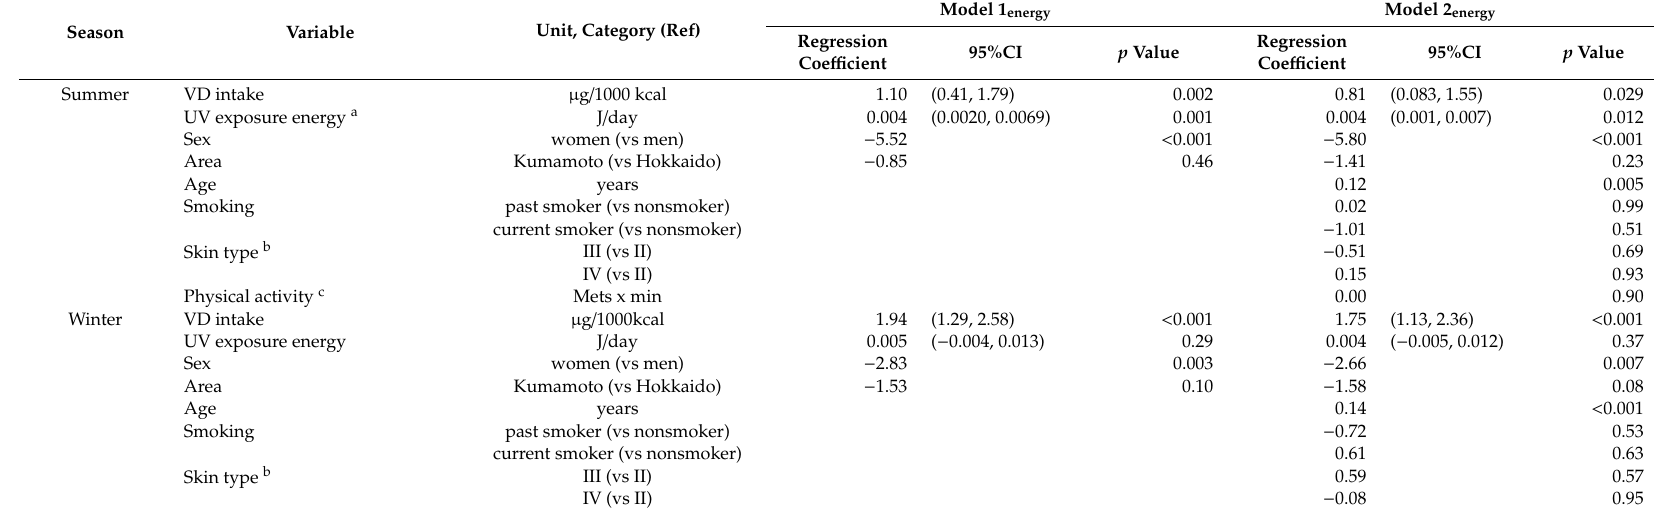
Table 3. Relationship between dietary vitamin D intake, UV exposure energy and serum 25(OH)D 3 concentration by season among Japanese adults ( n =